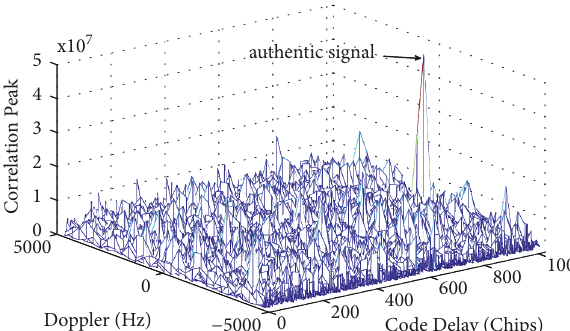
Figure 9: Acquisition of PRN25 with